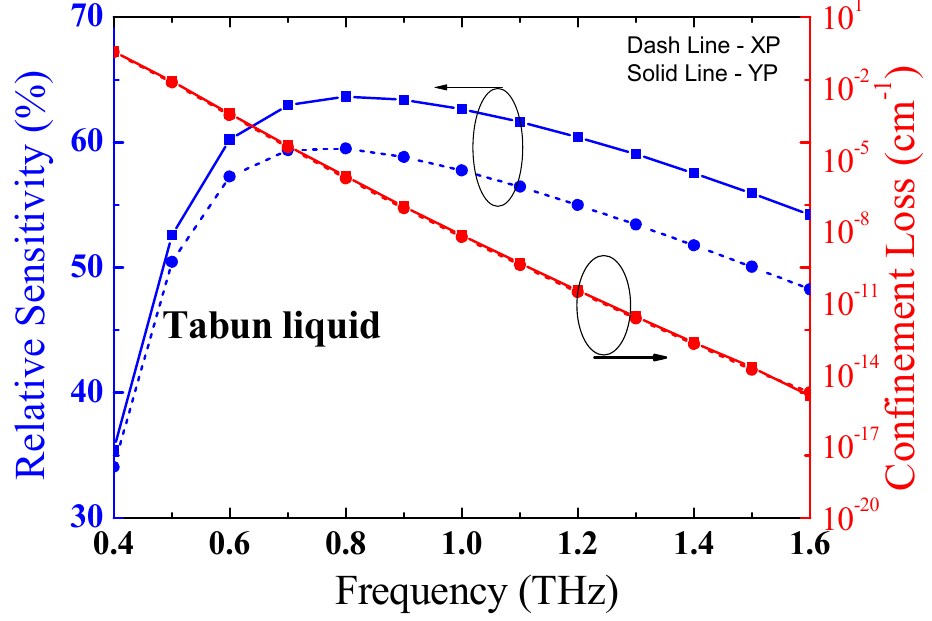
Figure 11. Relative sensitivity and confinement loss of the proposed sensor when the QE air holes were filled with tabun liquid.